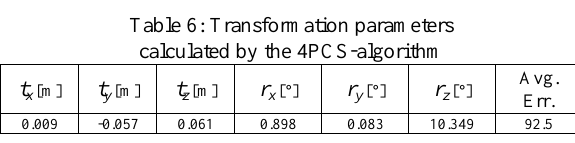
Table 4: Transformation parameters calculated with Cyclone Res.